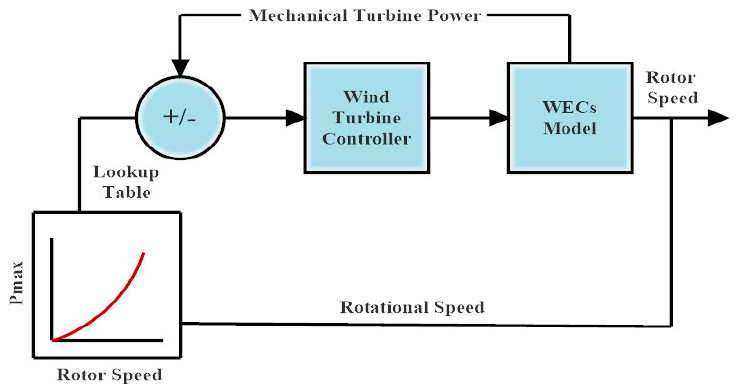
Figure 10. Basic block diagram of PSF.